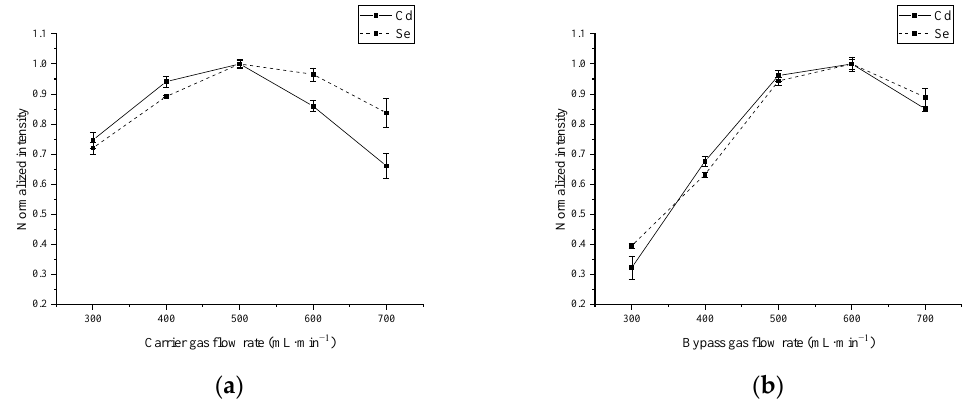
Figure 4. The effect of carrier and bypass gases on Cd and Se signal intensities. The other operational parameters are consistent with Table 3. A rice sample (GBW 10045a rice sample, Cd = 320 ± 40 ng g − 1 and Se = 60 ± 1 ng g − 1 ) was employed for slurry sampling. ( a ) The effect of carrier gas on Cd and Se signal intensities. ( b ) The effect of bypass gas on Cd and Se signal intensities.